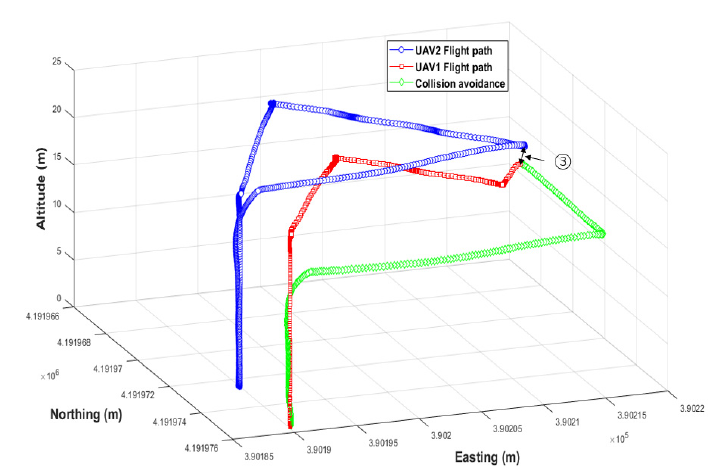
Figure 17. Simulation of flight trajectory with the collision avoidance algorithm.